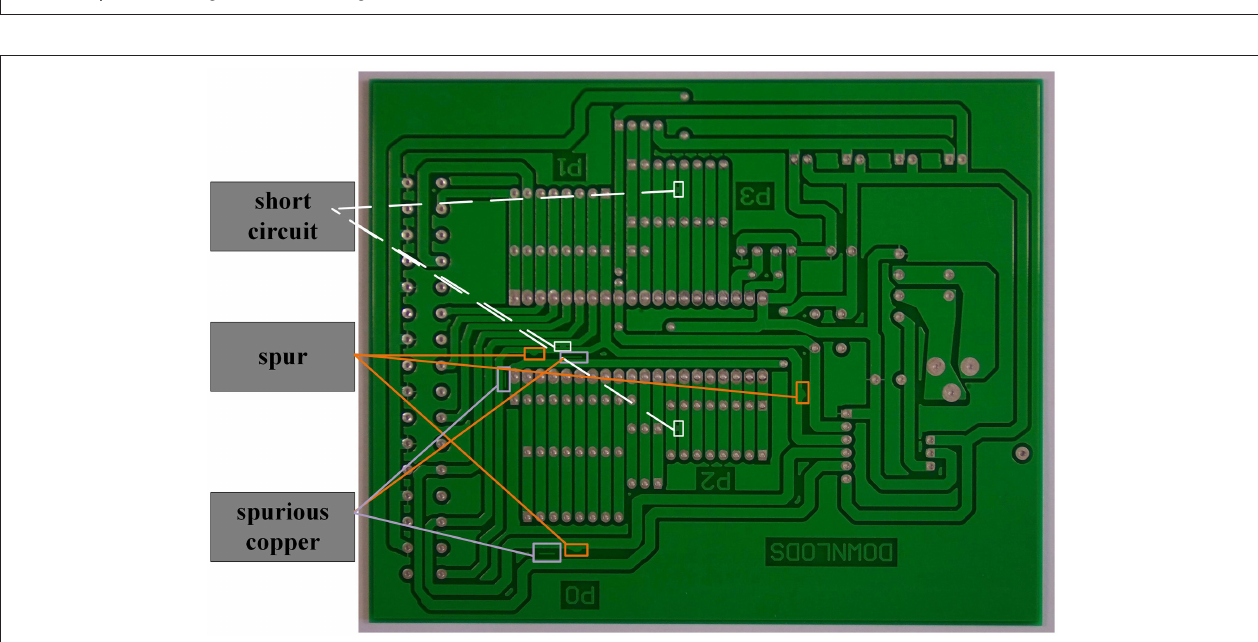
FIGURE 3 | The PCB image label with labelling.